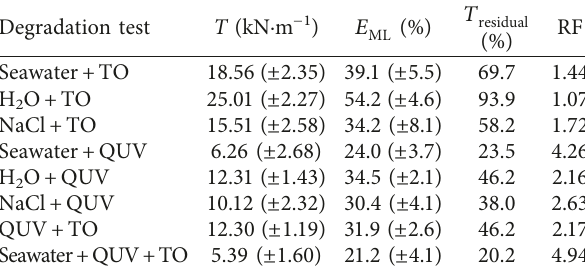
Table 4: Tensile properties of the geotextile after the multiple exposure degradation